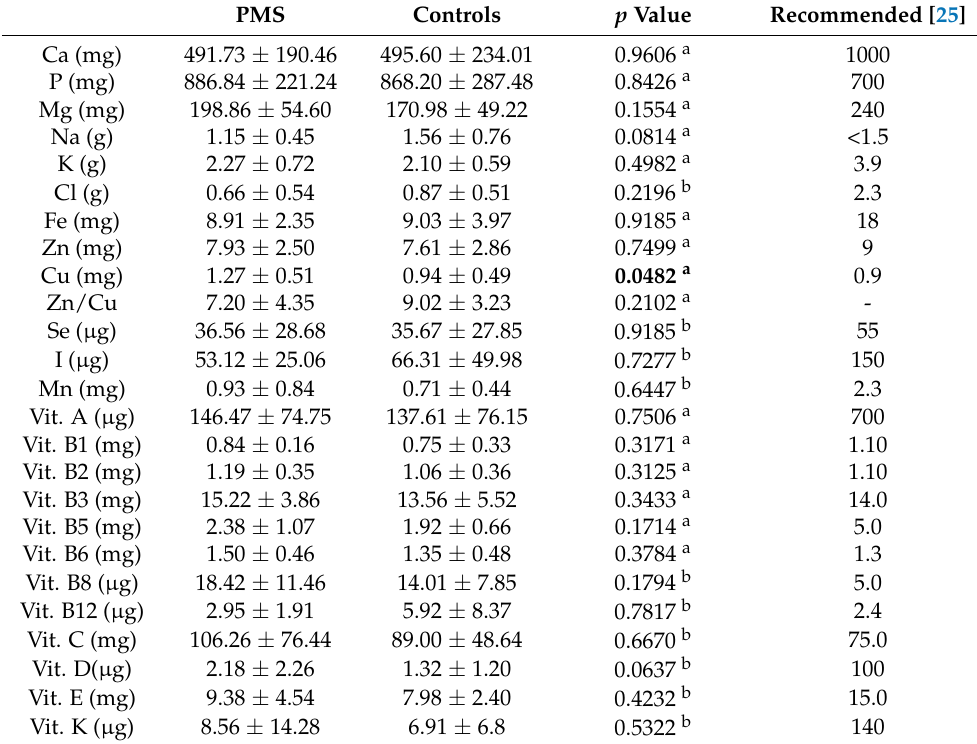
Table 5. Estimated daily intakes of micronutrients in participating women.